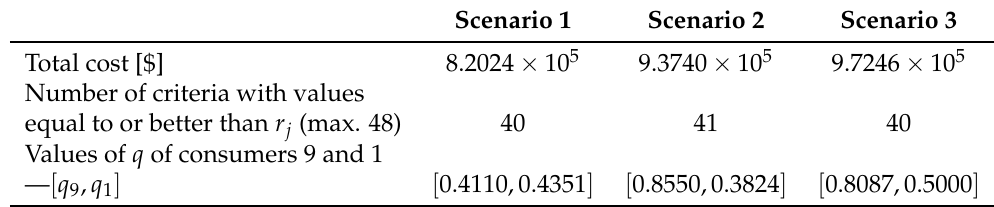
Table 4. Results of numerical tests—simple market.